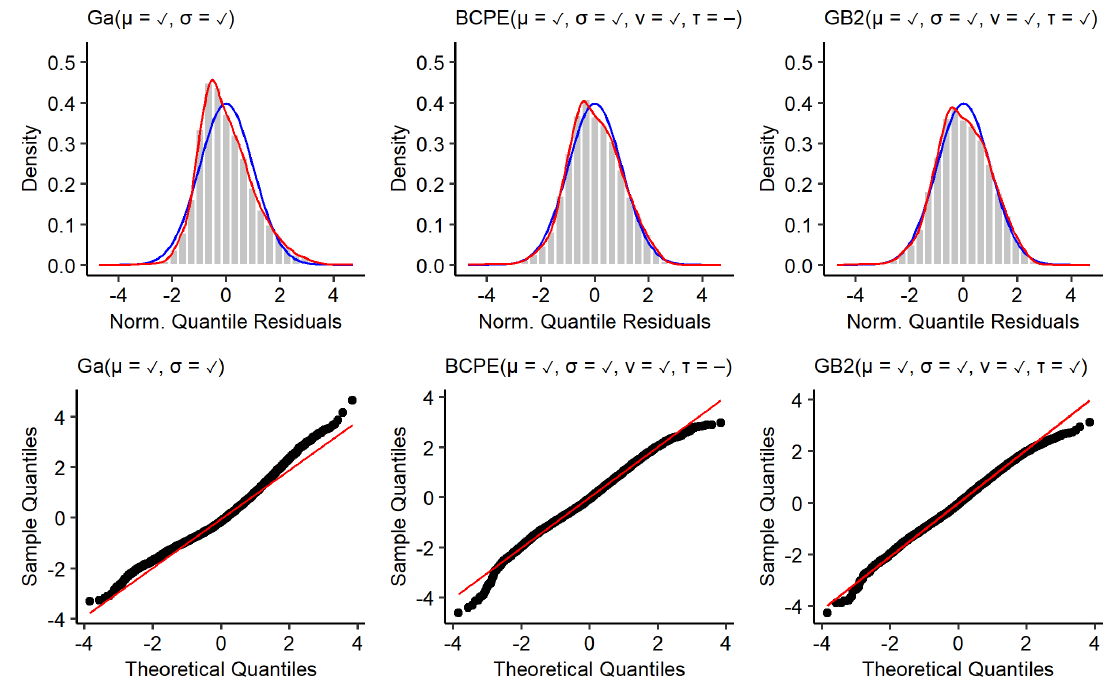
Figure A1. Residuals of models estimated with the male training data. Top : Histogram and kernel density estimate of normalised quantile residuals with standard normal distribution (blue). Bottom : Quantile–quantile